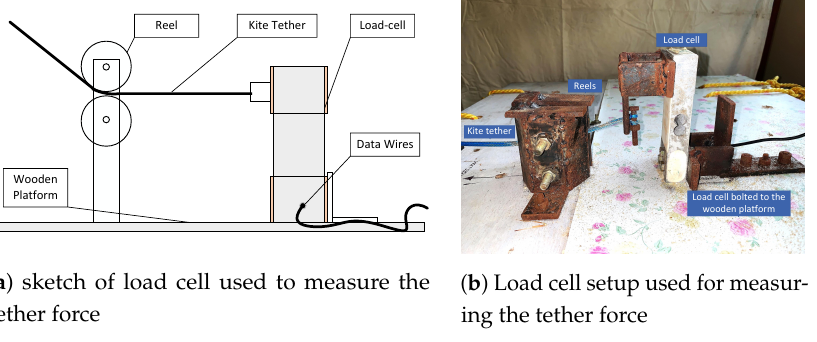
Figure 9. Measurement of tether force using lad-cell, ( a ) shows the pictorial representation of the setup, ( b ) shows the actual setup mounted on the wooden board in which the tether is passed through the pulleys. Table 3. Data logged in the field tests consisting of orientation in quaternion form, altitude, GPS data, load-cell values, wind speed, and wind